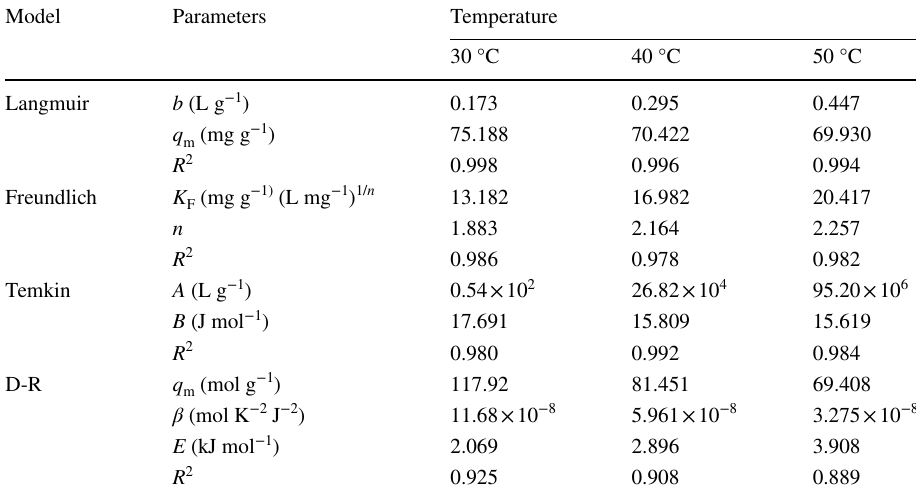
Table 3 Adsorption isotherm parameters for adsorption of crystal violet dye on PGADP at 30, 40 and 50